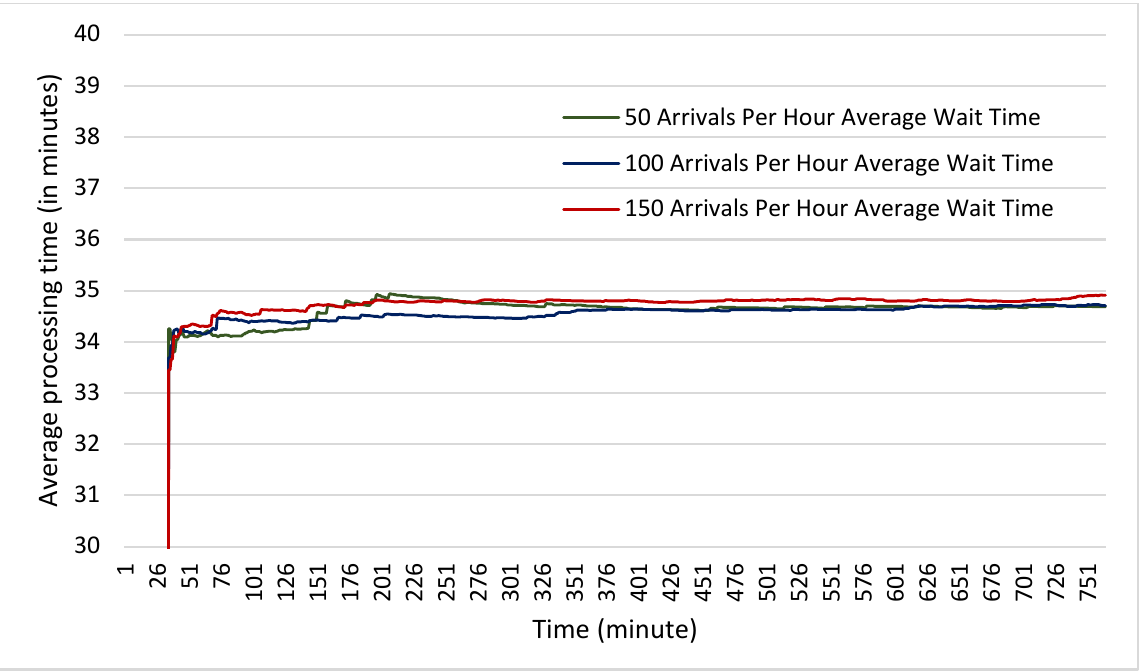
Figure 5. Average time spent waiting by clients at each of the arrival rates for a facility with no physical distancing measures measured in minutes.